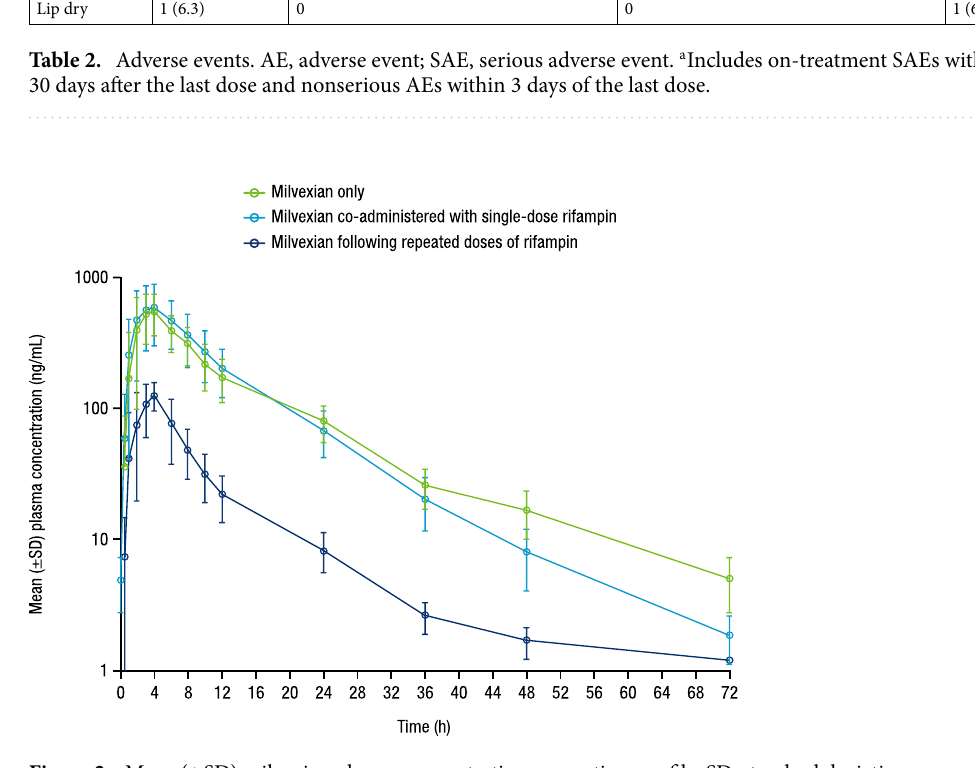
Figure 2. Mean (± SD) milvexian plasma concentration versus time profile. SD, standard